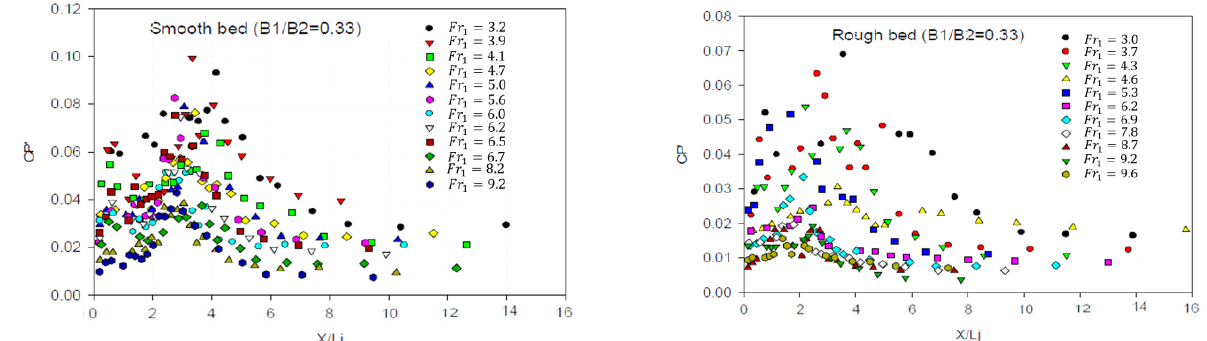
Figure 7. 𝐶 𝑃′ parameter for expansion ratio of 0.5.